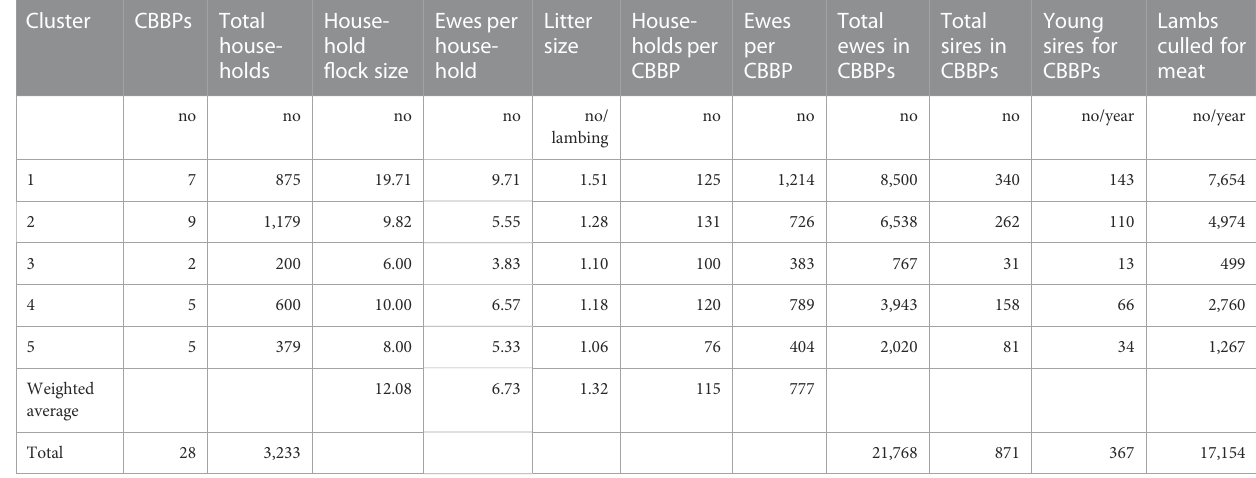
TABLE 1 Current community-based breeding program (CBBP) statistics per geographical production